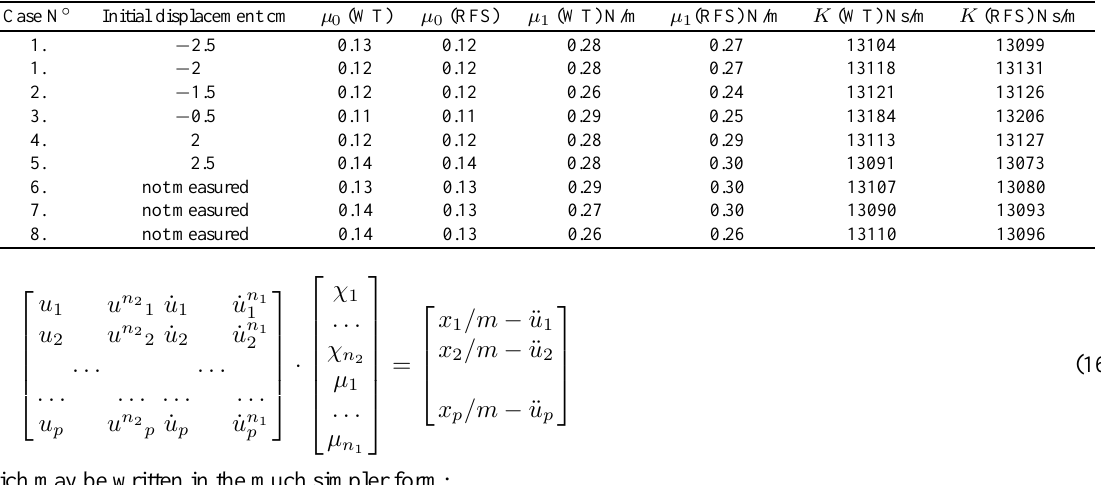
Table 1 Identified parameters of the low dissipation